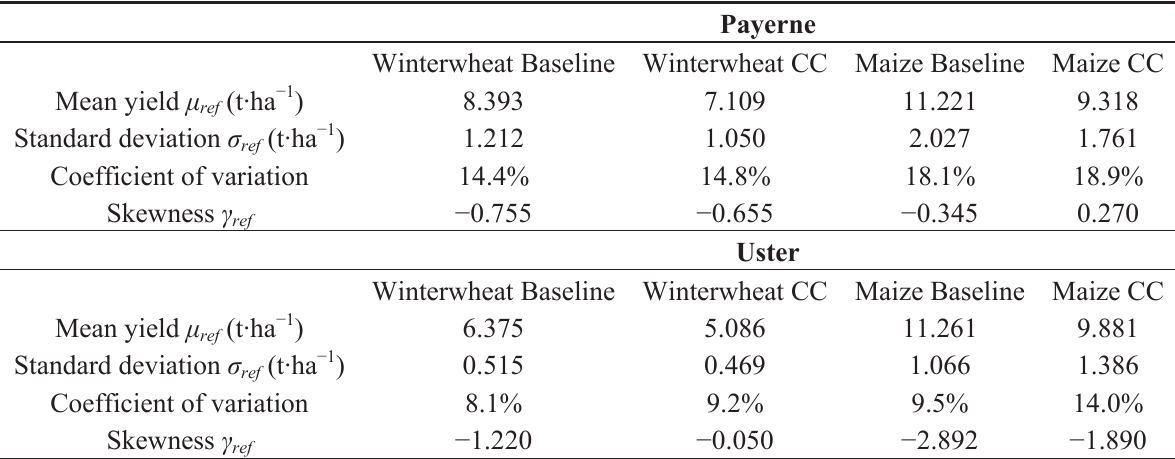
Table 1. Statistical moments of simulated yield